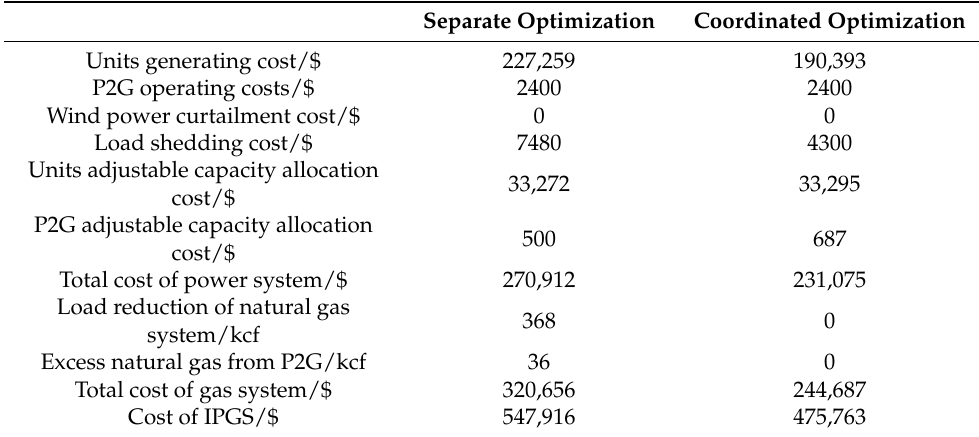
Table 3. Dispatch results of two scheduling